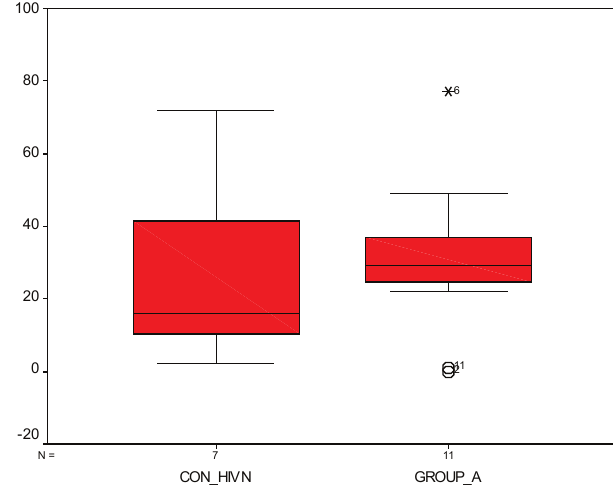
FIGURE 1 – Boxplot – Comparison of Langerhans cell populations between HIV-negative control group and Group A.